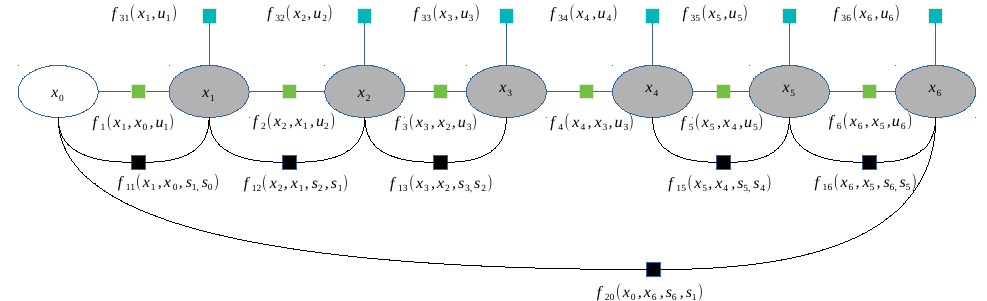
Figure 13. Used factor graph. Factors from f 1 to f 6 are odometry factors. Factors from f 11 to f 16 are observation factors. Factors from f 31 to f 36 are IMU prior factors. Factor f 20 is a loop closure. Note that the observation factor that connects pose x 3 and x 4 does not exist, due to failed NDT matching. The variables u 1 to u 6 are robot odometry readings. The variables s 1 to s 6 are scans taken near the corresponding poses.